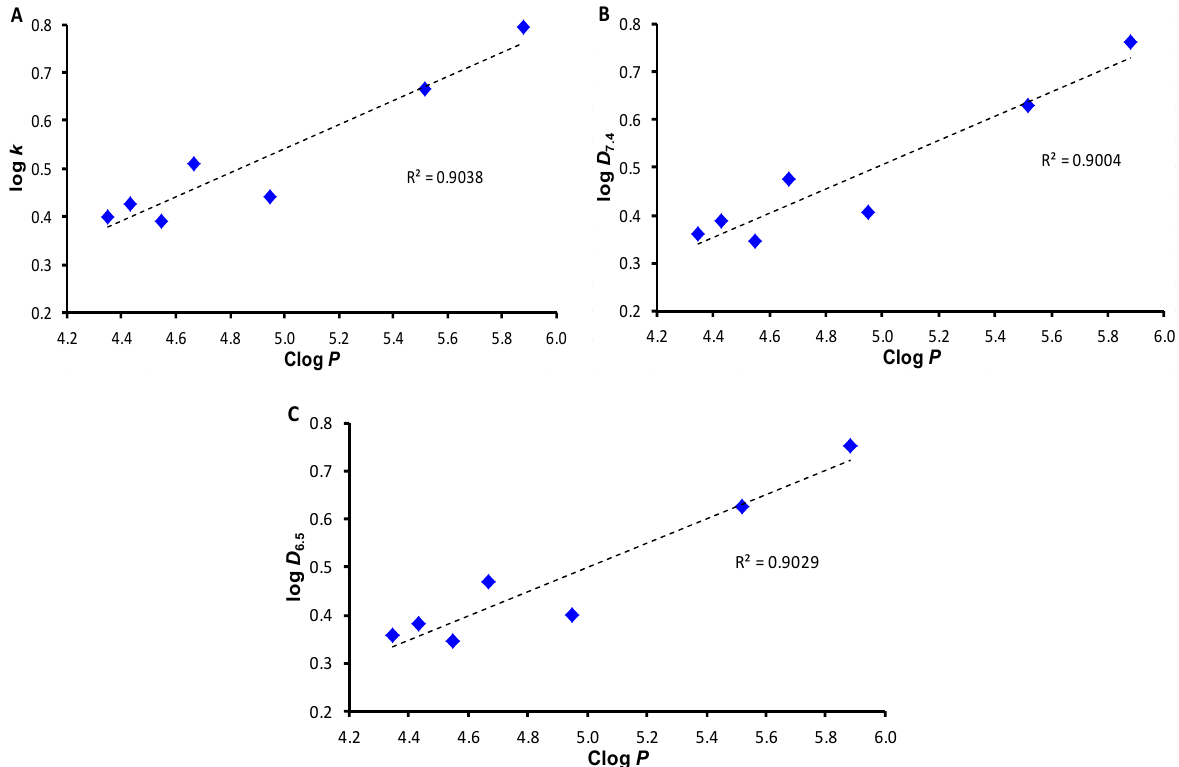
Figure 2. Comparison of predicted Clog P (ChemBioDraw) values with experimentally found log k ( A ), log D 7.4 ( B ), and log D 6.5 ( C ) values of ring-substituted (2 E )- N -aryl-3-[2-(trifluoromethyl)- phenyl]prop-2-enamides 1 – 7